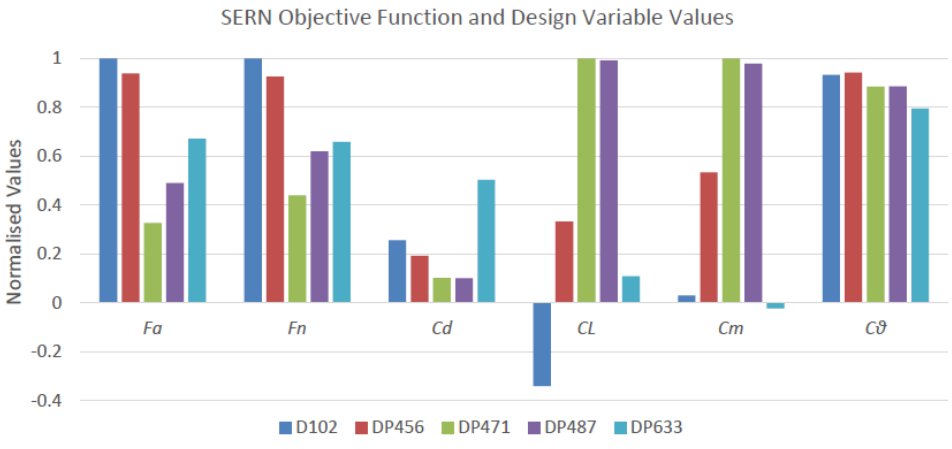
Figure 14. SERN geometries achieving best performance parameters for BCC 3.1. Table 9. SERN geometries for best performance.